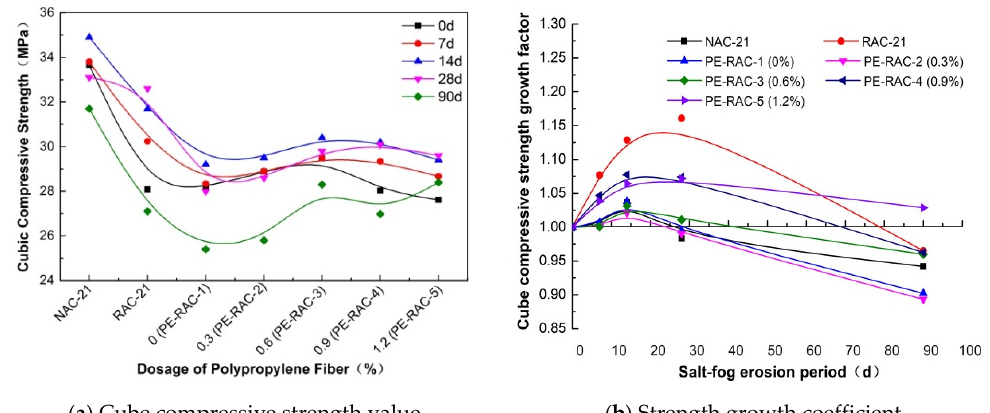
Figure 2. Influence of waste fiber content on cube compressive strength.